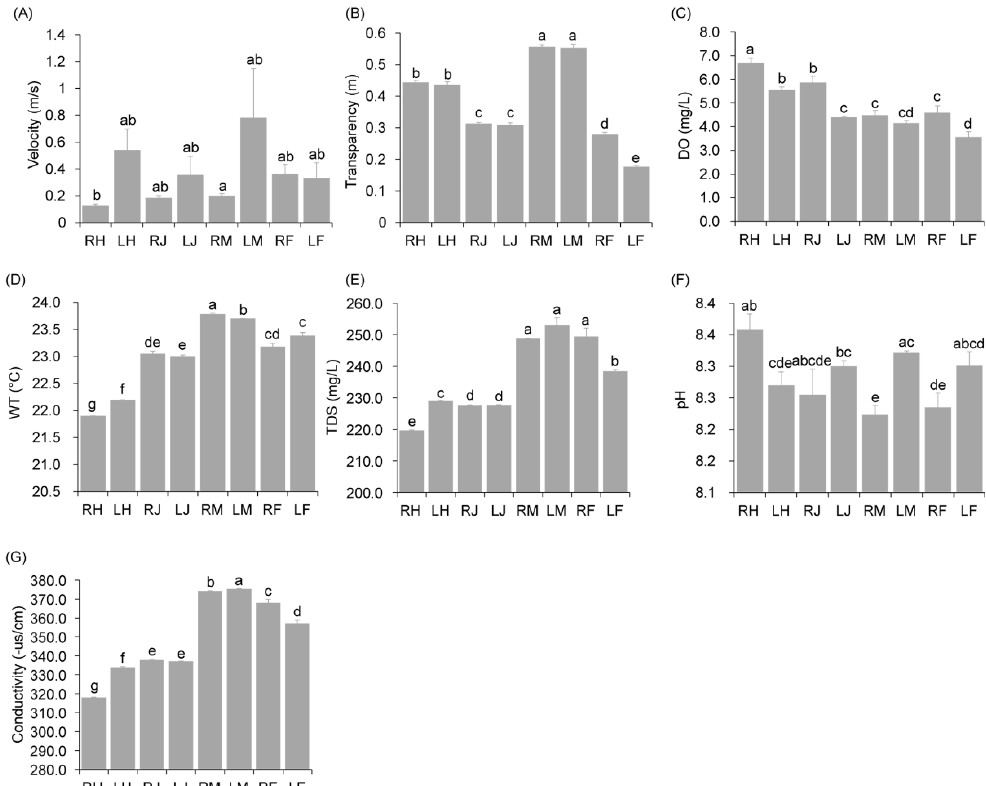
Figure 2. Histogram profiles of water physical and chemical factors in the sampling sites. ( A ), average water velocity in the sampling sites; ( B ), average water transparency in the sampling sites; ( C ), average dissolved oxygen (DO) of the water in the sampling sites; ( D ), average water temperature (WT) in the sampling sites; ( E ), average total dissolved solids (TDS) of the water in the sampling sites; ( F ), average water pH value in the sampling sites; ( G ), average water conductivity in the sampling sites. RH, right bank at Hejiang; LH, left bank at Hejiang. RJ, right bank at Jiangjin; LJ, left bank at Jiangjin; RM, right bank at Mudong; LM, left bank at Mudong; RF, right bank at Fengdu; LF, left bank at Fengdu. The different lowercase letters above the bars show the significant differences among the groups ( p < 0.05).